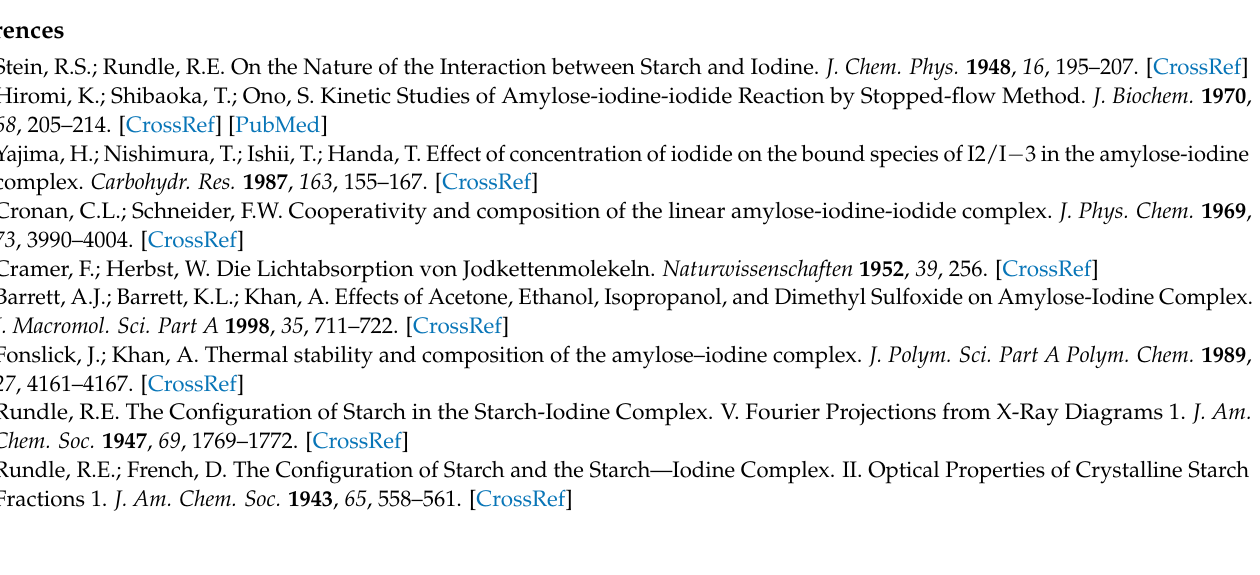
amounts of solution I 2 in methanol 10 mM were added, Figure S8: UV-vis spectra of water, to which I 2 from a 10 mM stock solution was added, followed by indicated amounts of 0.5% starch solution, Figure S9: UV-vis spectra of starch solutions to which indicated amounts of I 2 1 mM aqueous solution were added, Figure S10: Corrections made to spectra from Figure S9 by subtracting the control spectra of I 2 at indicated concentrations, Figure S11: UV-vis spectra of a 1 mM I 2 aqueous solution, to which indicated amounts of starch 0.5% solution were added, Figure S12: UV-vis spectra of starch 2% glucose 1 mM to which 5 µ L solution of iodine-iodide aqueous solution were added, Figure S13: UV-vis spectra of starch 0.5%, to which iodine-iodide was added, Figure S14: Same spectra as in Figure S13, now corrected by subtracting the control spectra of iodine-iodide solutions collected in the absence of starch, Figure S15: UV-vis spectra of an iodine-iodide aqueous solution to which indicated amounts of starch 0.5% solution were added, Figure S16: Same spectra as in Figure S15, now corrected by subtracting the control spectra of starch solutions collected in the absence of iodine, Figure S17: Same spectra as in Figure S16, multiplied by arbitrary constants each, so that a clearer comparison of the shapes of the maxima can be offered, Figure S18: Time evolution of UV-vis spectra of an iodine-iodide mixture, to which starch and amylase were added, Figure S19: Same spectra as in Figure S18, now corrected by subtracting the control spectrum of the iodine-iodide solution, Figure S20: Structures of AM1-optimized amylose models, in order of rows: A, A-H 2 O, A-I 2 , A-I 2 -H 2 O, A-I 3- , Figure S21: Structure of the amylose model helix, showing in yellow highlight the atoms employed for estimating the changes in helix length/diameter (as discussed in main text, Table 1), Table S1: Key distances (Å) derived computed for iodine-amylose models, Table S2: AM1 energies (kcal/mol) of amylose models employed in the present study, Table S3: Solvent effects on TD-DFT-predicted maxima and oscillator strengths for selected iodine/iodide